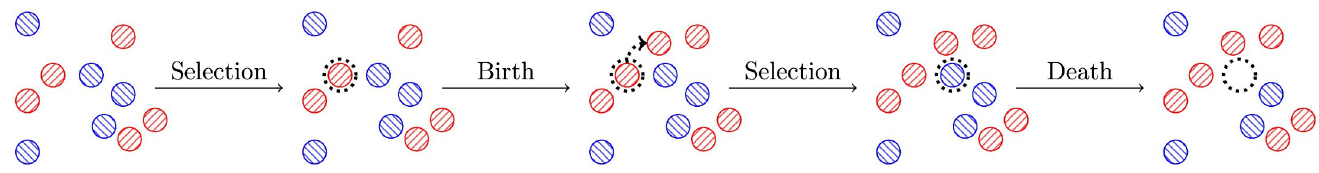
Fig 1. A diagrammatic representation of a Moran